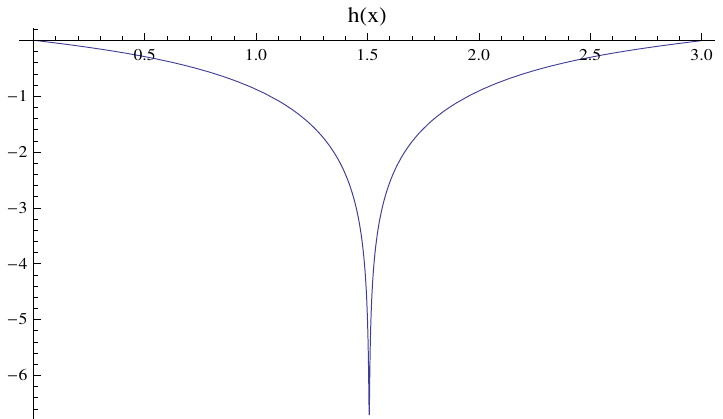
Figure A5. Plot of ln | ψ | in a symmetric solution with ∆ ϕ (cid:39) 3.14, L =